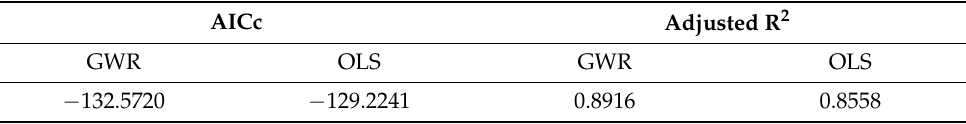
Table A5. The results of GWR and OLS analysis including the PD and five5 selected independent